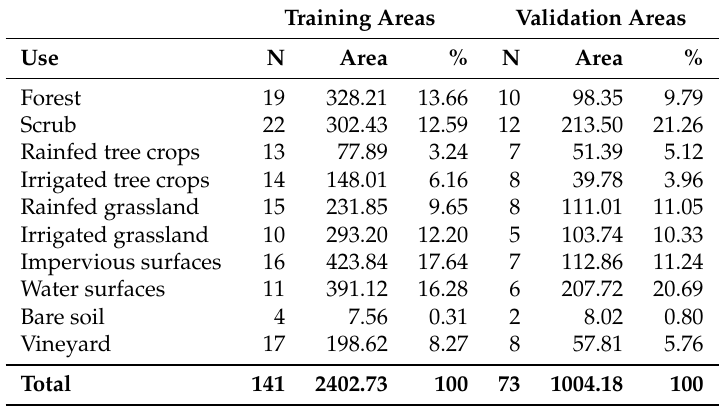
Table 2. Number and area (ha) of training and validation areas. Water surfaces include some sea polygons. The percentages refer to the areas. Bare soil was initially included within the scrub class, but because of its different reflectivity, we have considered it as a new